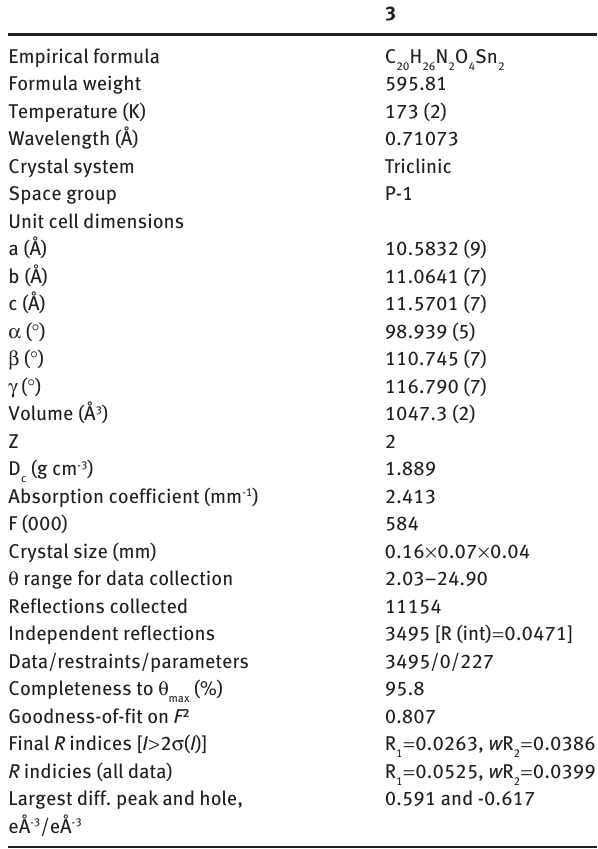
Table 1 Crystal data and structure refinement for compound 3